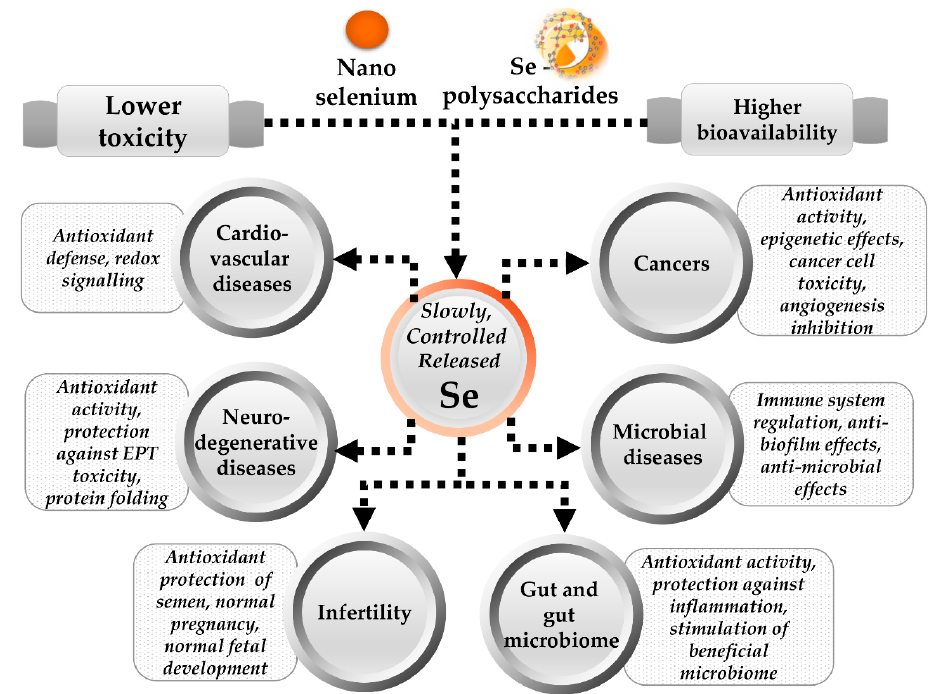
Figure 2. Potential benefits of the next-generation dietary supplements based on nanoselenium and selenium polysaccharides. The new forms of selenium ingredients were proven, in several experimental models, to have lower toxicity and higher bioavailability. The biological activities of such putative slow, controlled-release selenium forms are not limited to the already known effects of selenium. Additional effects, such as in vitro inhibition of biofilm formation by the multi-antibiotic resistant pathogenic bacteria or stimulation of beneficial microbiome on chicken, were recently reported for these new forms of selenium. Data were obtained from References [14,33,37,41,74–79]. The bioavailability and biological activity of selenium depend not only on the total ingested amount, but also on its chemical form, solubility, digestibility and accessibility, the presence of other dietary components, and the physiological status of the organism [25,80,81]. The organic forms are less toxic and are absorbed more effectively (especially SeMet) than the inorganic ones [82,83]. Inorganic Se (Se +4 and Se +6 ) is 40 times more toxic than organic Se [84], and Se +4 is nearly 10 times more toxic than Se +6 according to the US Environmental Protection Agency (EPA) report (FRL–5649–7) [85]. In terms of human nutrition, organic compounds have a higher bioavailability and are assimilated from food/supplements in ranges of 85%–95%, while the uptake range for inorganic selenium is 40%–50% [86]. The most abundant specie in Se-yeast was found to be SeMet, but there are over 60 types of Se species reported [24]. The common method of characterizing and comparing Se-yeast was by quantifying the total SeMet content, and the speciation analysis traditionally involves the determination of low-molecular-mass selenospecies. This approach has the disadvantage that it does